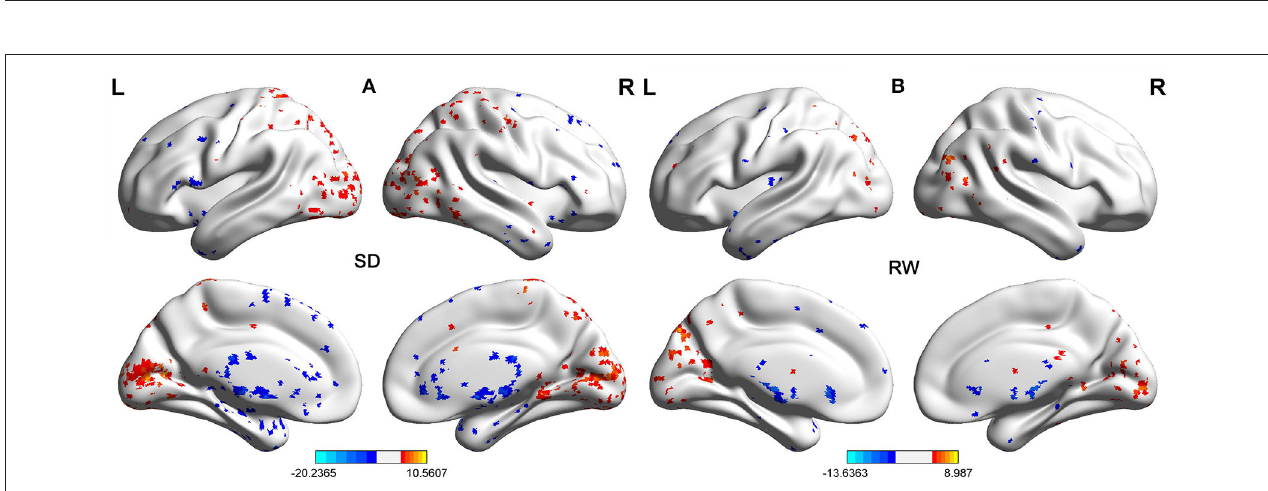
FIGURE 2 | One sample t -test differences of SD and RW in Binarized shortFCD. The Binarized shortFCD maps in the SD group (A) and the RW group (B) , respectively. These maps are the results of the within-groups using one-sample t -tests, corrected by FDR. L, left; R, right; SD, sleep deprivation; RW, rested wakefulness; shortFCD, short-range functional connectivity density; FDR, false discovery rate.